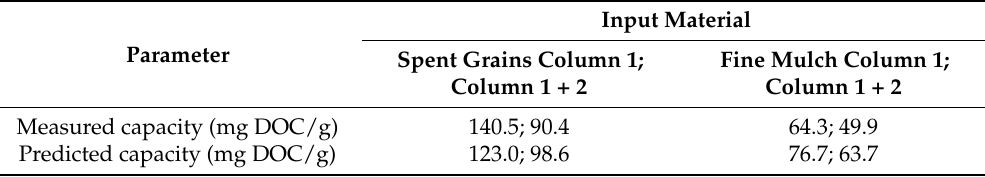
Table 6. Comparison between measured and predicted column capacities.